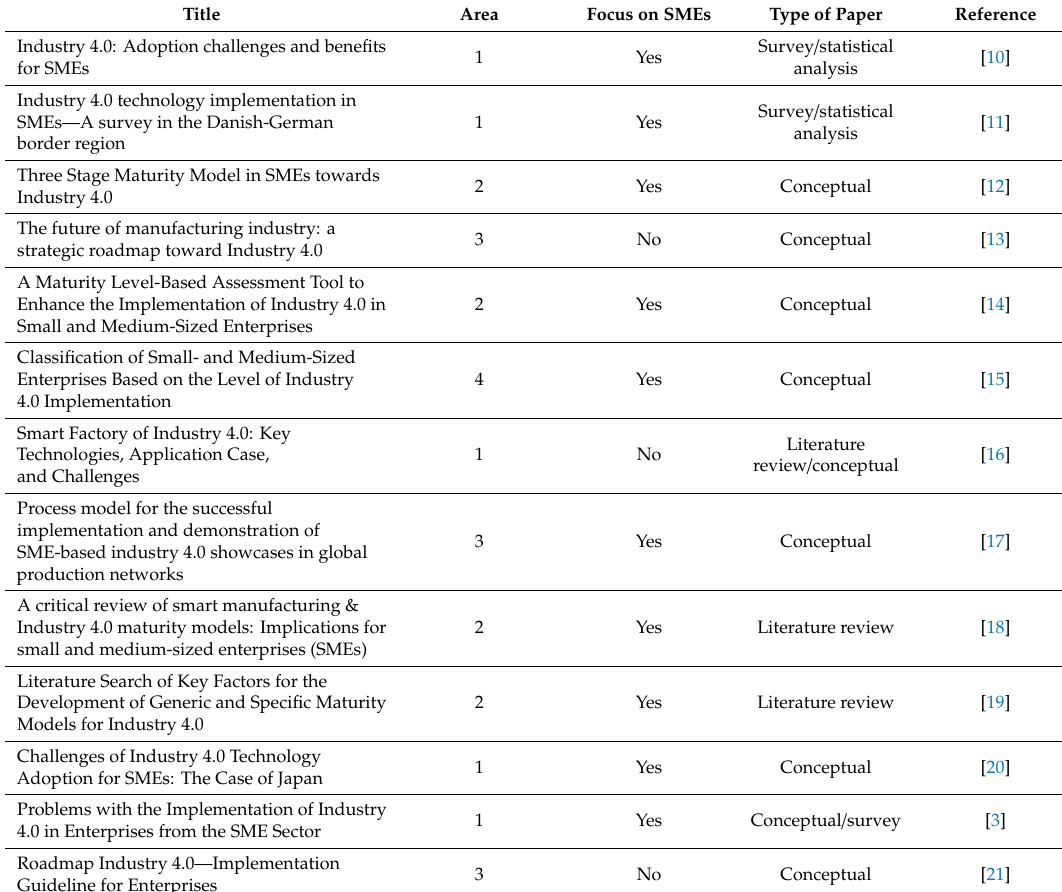
Table 1. Literature review to identify the research gaps in this area. SMEs: small and medium-sized enterprises. Area Focus on